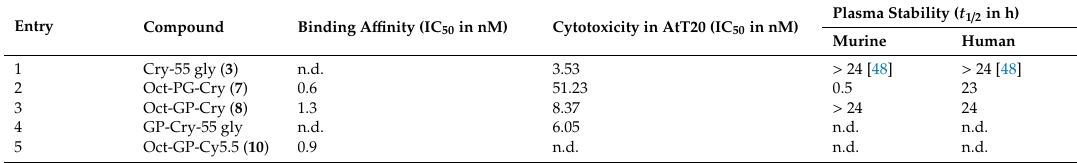
Figure 1. ( A ) Binding a ffi nity towards SSTR2 of free ligand (octreotide), conjugates 7 , 8 , and 10 . ( B ) in vitro cytotoxicity of the compounds 3 , 7 , and 8 and metabolite Gly-Pro-Cry-55gly in the AtT20 cell line. ( C ) Plasma stability of conjugates 7 and 8 in murine and human plasma. Table 1. Binding a ffi nities, cytotoxicity, and plasma stability of cryptophycin-55 glycinate ( 3 ), metabolite GP-Cry-55 gly, and conjugates 7 , 8 , and 10 (n.d.: not